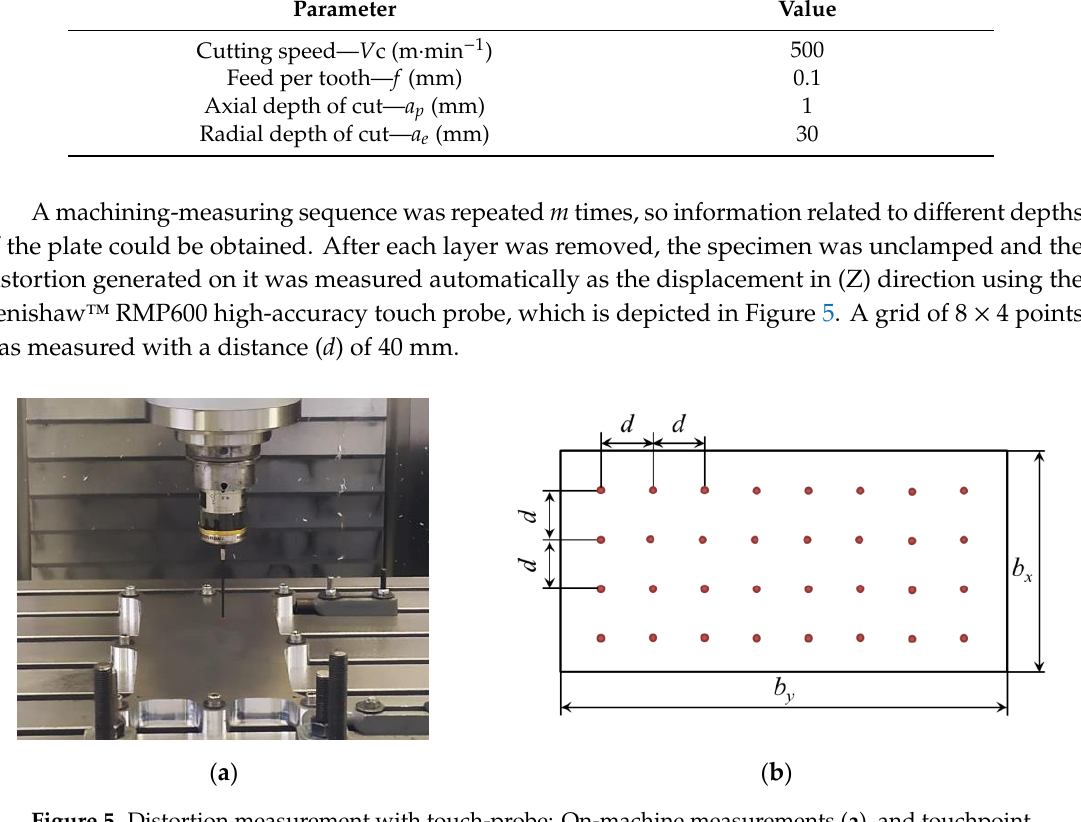
Figure 5. Distortion measurement with touch-probe: On-machine measurements ( a ), and touchpoint grid ( b ).